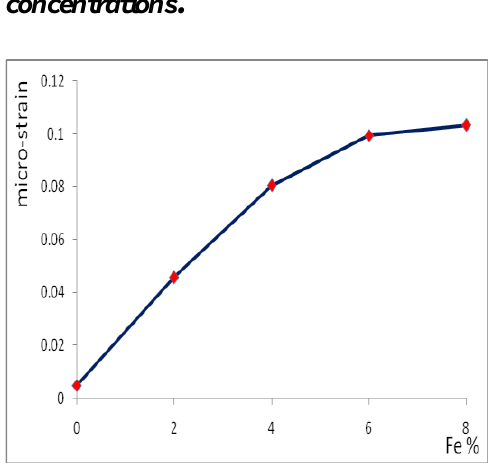
Fig. 3: The variation of micro-strain (ε) for ZnO thin film with Fe doping concentrations.